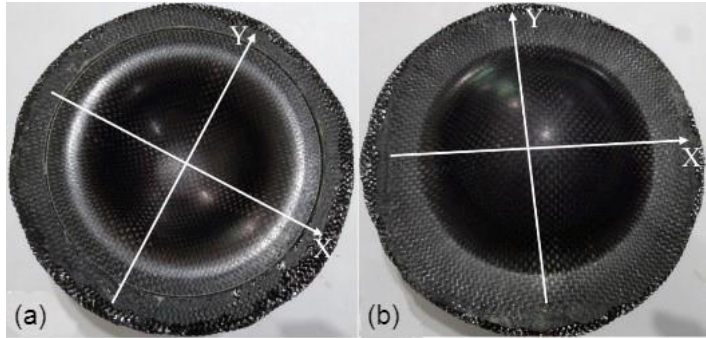
Figure 5. Deep drawing of composite-15 specimen: ( a ) front view, ( b ) back view.